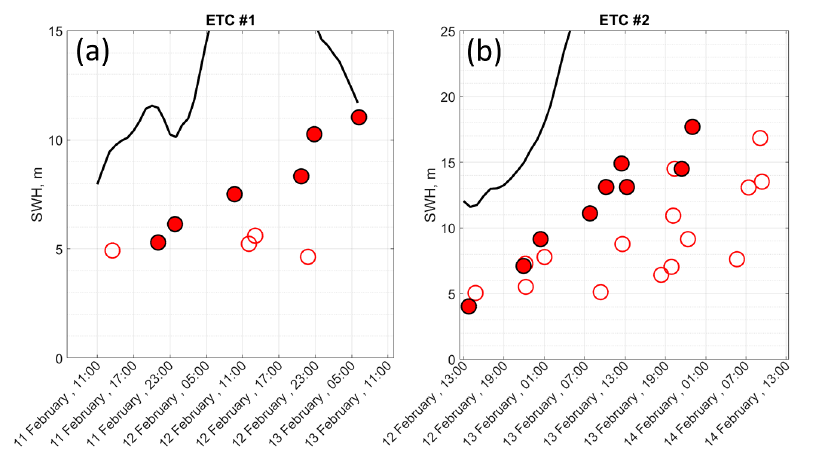
Figure 10. Time evolution of maximum SWH values for ETC#1 ( a ) ETC#2 ( b ). The filled red circles are related to the SWH of wind waves ( α > 0.85), and the open red circles—to the SWH of swell. The black curves show the SWH of fully developed waves calculated for local u m